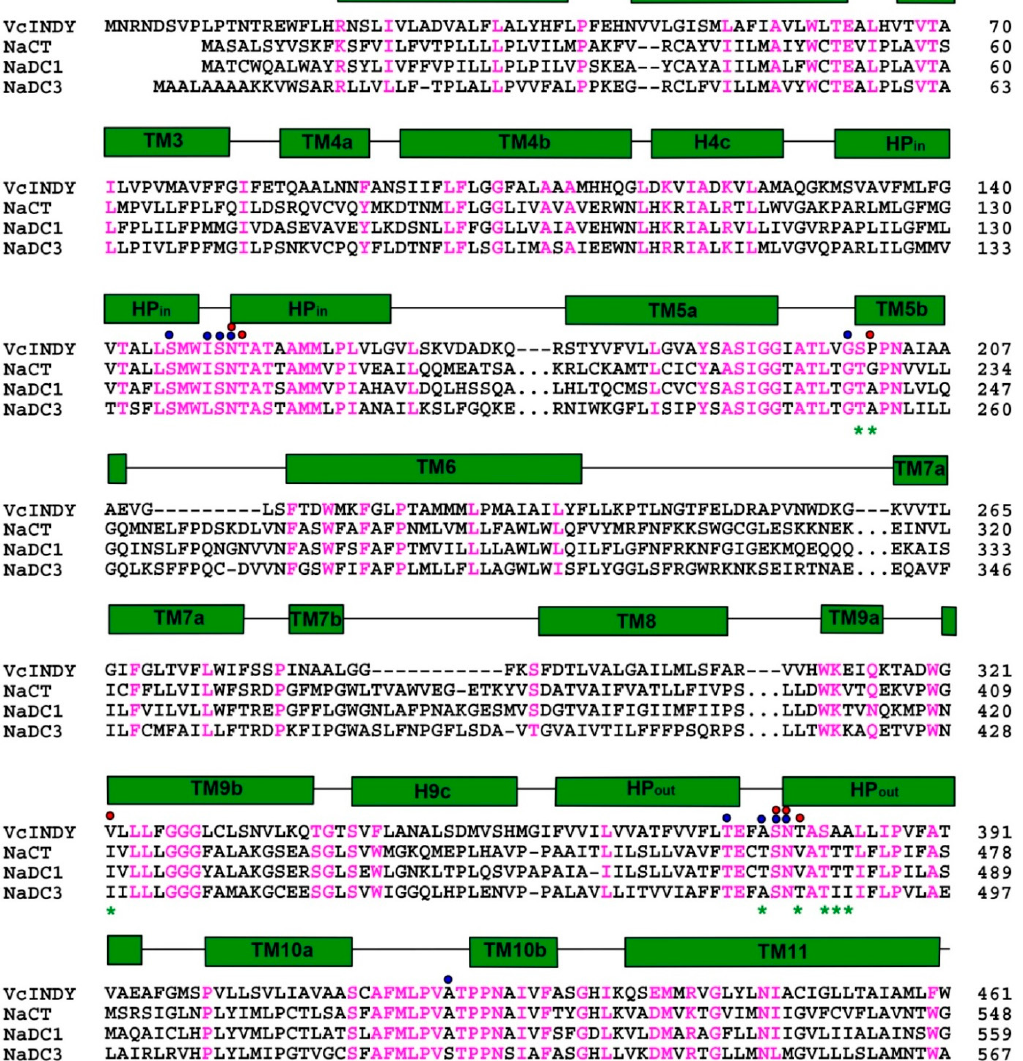
Figure 2. Amino-acid sequence alignment of representative DASS proteins. Residues conserved among VcINDY and three human orthologues are colored magenta, regions of secondary structural elements in VcINDY are outlined, with transmembrane helices shown as green rectangles. Red and blue dots highlight amino acids that bind succinate/citrate and Na + , respectively. Positions for the relevant humanizing mutations, which include S200T, P201G, V322I, T379V, A376T, S381T, A382T, and A383T, are marked by green asterisks. For clarity, some residues in the human DASS proteins were omitted and indicated by “…”. Notably, the amino-acid sequence identity between VcINDY and NaCT is 23%, but the degree of sequence conservation in and around the citrate- and Na + -binding sites is substantially higher, suggesting that the VcINDY structure provides a useful model for studying the mechanism of NaCT or other human DASS. Sequence alignment was performed by using the program ClustalW.